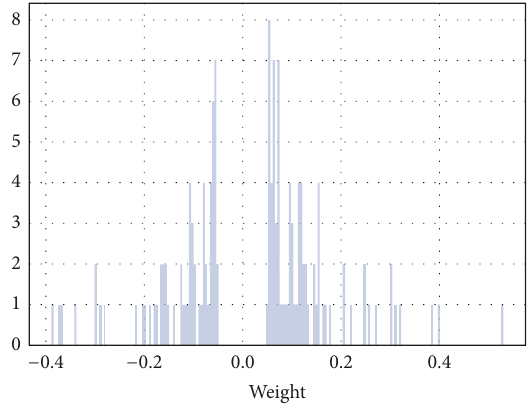
Figure 2: Distribution of weights in partial correlation network ( 𝐿 = 144